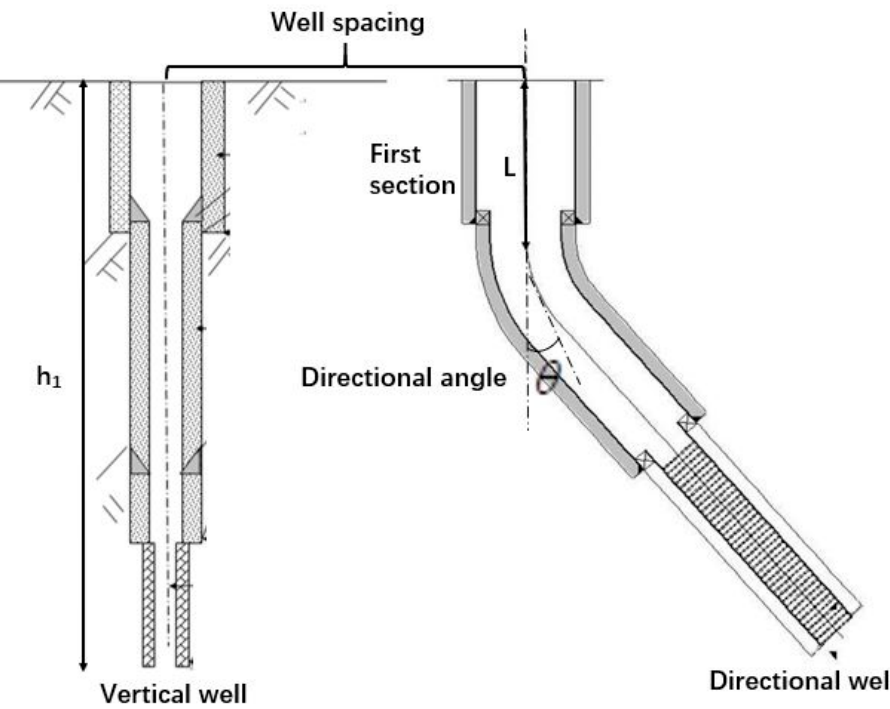
Figure 4. Schematic diagram of vertical well and directional well.